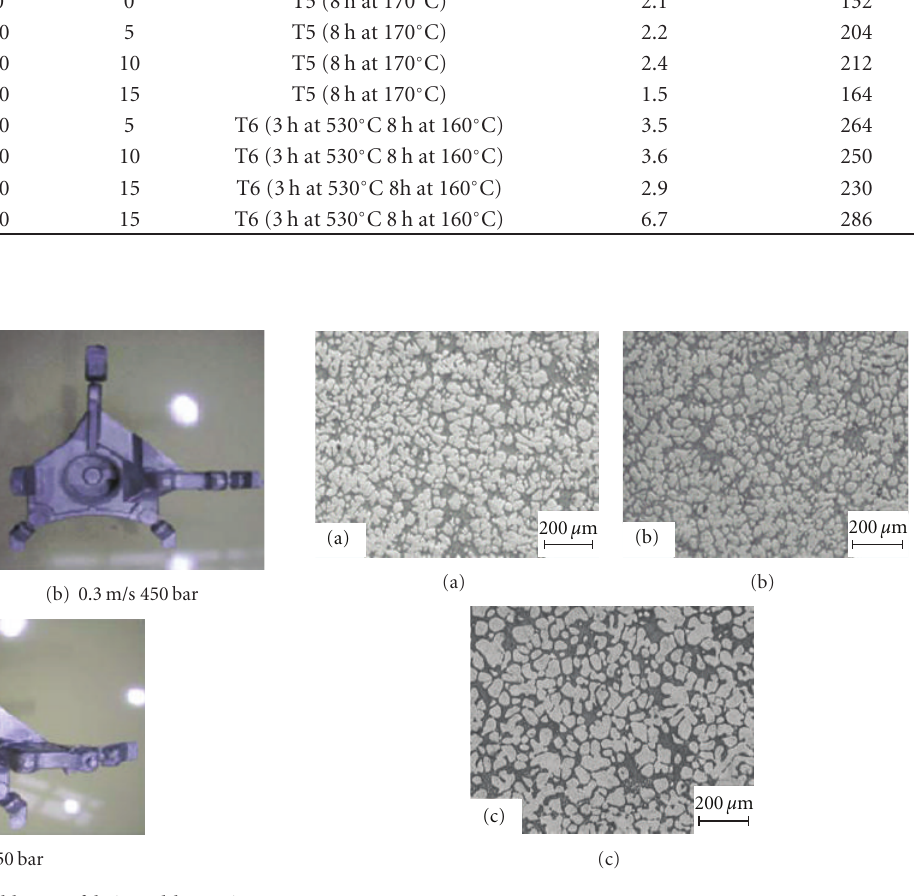
Figure 21: Photographs of the knuckle part fabricated by various casting conditions. Figure 22: Microstructure of knuckle part at stirring current 60 A